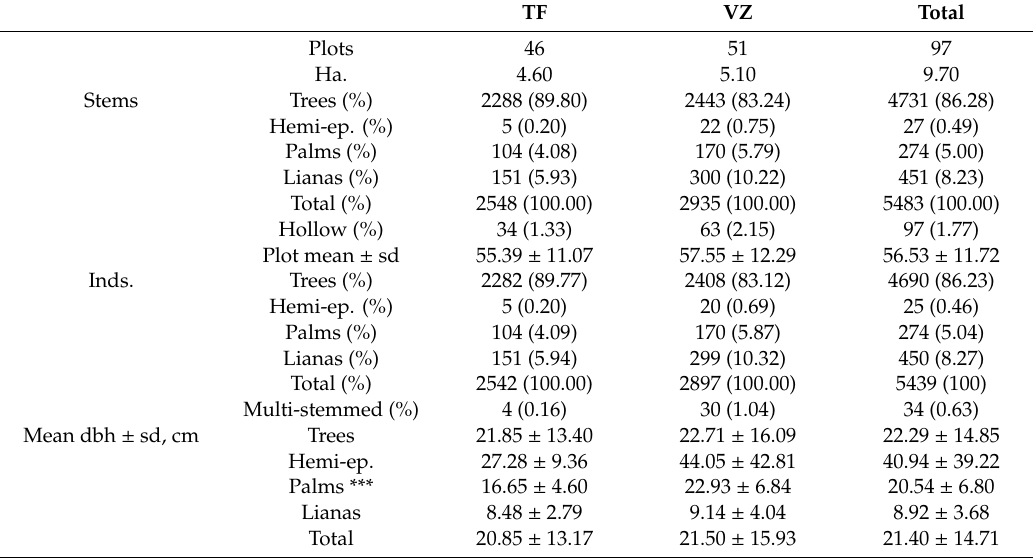
Table 1. Number of plots (Plots) and number of ha. (Ha.) inventoried in terra firme (TF) and v á rzea (VZ) forests along the Juru á River, western Brazilian Amazon. Number of stems (Stems), including hollow stems, and number of individuals (Inds.), including multi-stemmed individuals, are given as count data with percentiles in parentheses (%). Mean number of stems per plot (Plot mean) is given ± standard deviations (sd). Mean diameter at breast height (dbh) ± sd is in cm, basal area (BA) in m 2 and mean height ± sd in m. All values are given per growth form, forest type and for both forest types combined. Values refer to trees, palms and hemi-epiphytes (hemi-ep.) with dbh ≥ 10 cm and woody lianas ≥ 5 cm dbh. Total height in m is also given as overall minimum (Min), maximum (Max), median and mode values. Di ff erences in stem density, dbh, plot BA and mean total height between v á rzea and terra firme for normally distributed data were tested with classic Student’s two-sample t -tests where group variances were homogenous or Welch two-sample t -tests where group variances were heterogenous. Where data did not conform to normality, we used independent